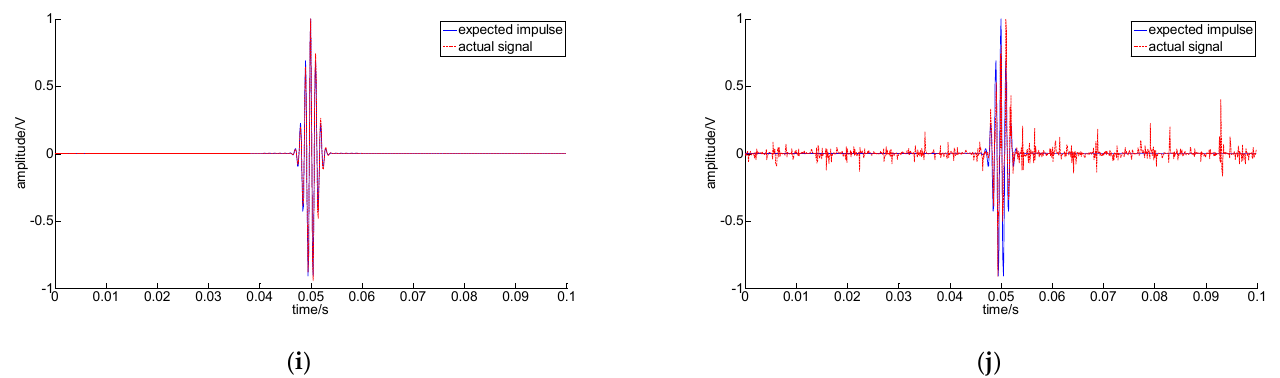
Figure 4. Preprocessed results of S 1 and S 2 with four different TEO methods: ( a ) simulated noise ‐ free signal S 1 ; ( b ) simulated noisy signal S 2 , and SNR= − 0.71 dB; ( c ) processed using the TEO for S 1 ; ( d ) processed using the TEO for S 2 ; ( e ) processed using the filtered TEO for S 1 ; ( f ) processed using the filtered TEO for S 2 ; ( g ) processed using the first derivative of the TEO for S 1 ; ( h ) processed using the first derivative of the TEO for S 2 ; ( i ) processed using the filtered first derivative of the TEO for S 1 ; ( j ) processed using the filtered first derivative of the TEO for S 2 . Table 1. Correlation of preprocessed impulses and expected impulses with different